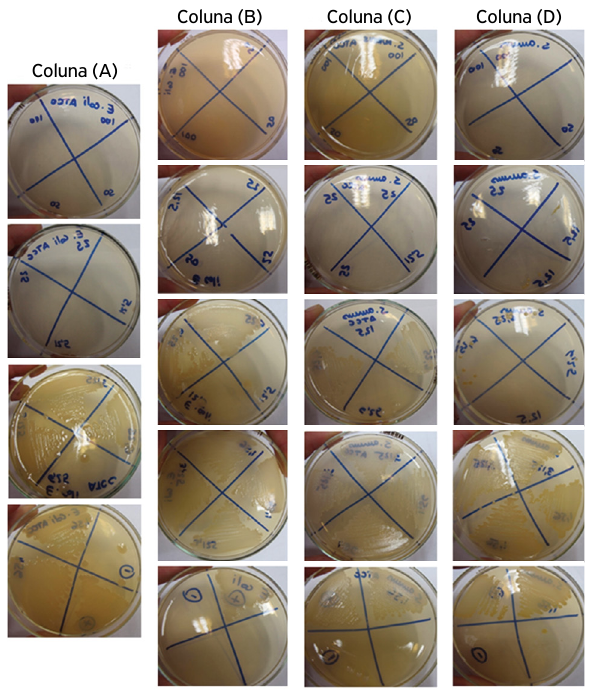
Figura 1. Placas semeadas com as culturas submetidas à ação das concentrações de 100 a 1,56 μL/mL do óleo essencial de orégano, além dos controles positivo e negativo. (A) E. coli (ATCC 25922), (B) E. coli clínica, (C) S. aureus (ATCC 25923) e (D) S. aureus clínica.